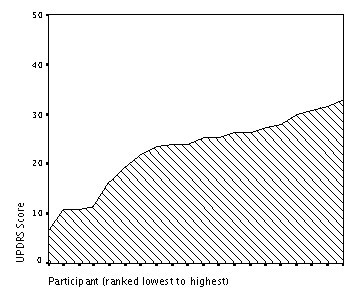
Area graph depicting the range of motor impairment in the cross-validation sample (20 patients, 20 controls).